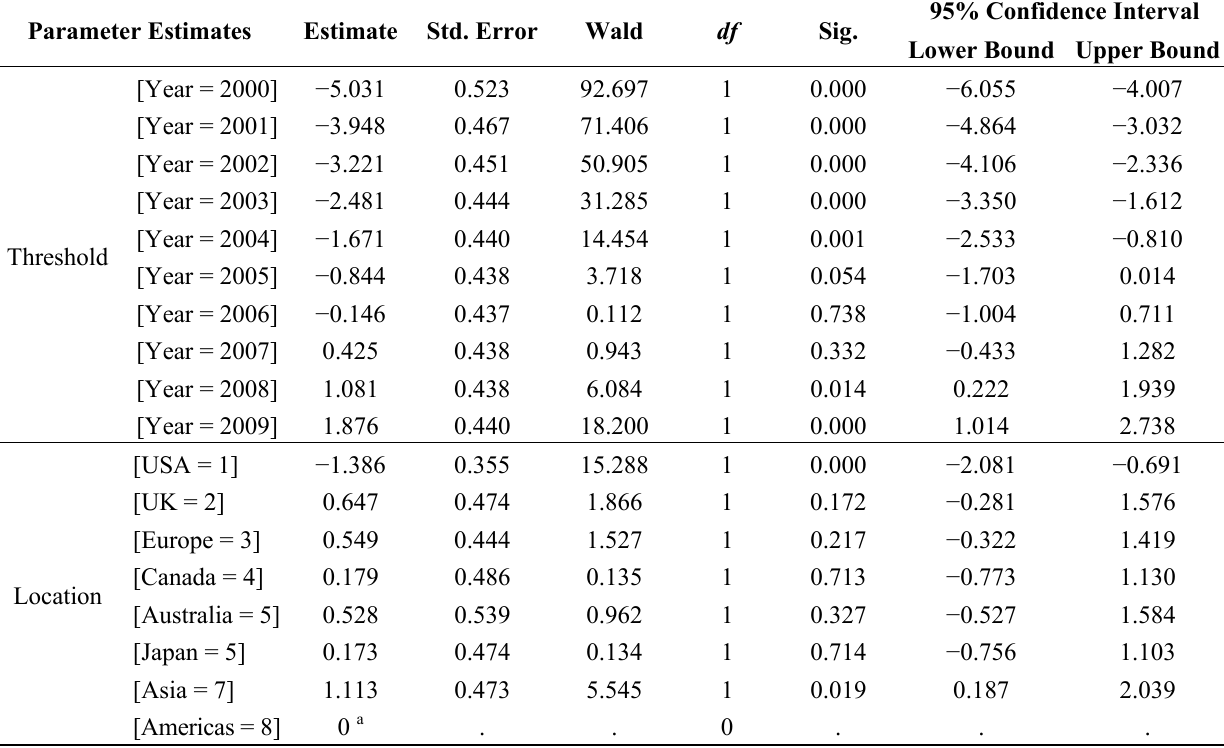
Table 1. An ordinal regression analysis of genomic data contributions to Genome Expression Omnibus (GEO) over the last decade by country/continent.